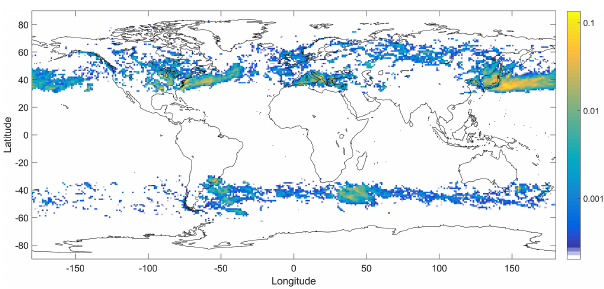
Figure 3. Global distribution of winter lightning stroke density (strokeskm − 2 yr − 1 ) for the period